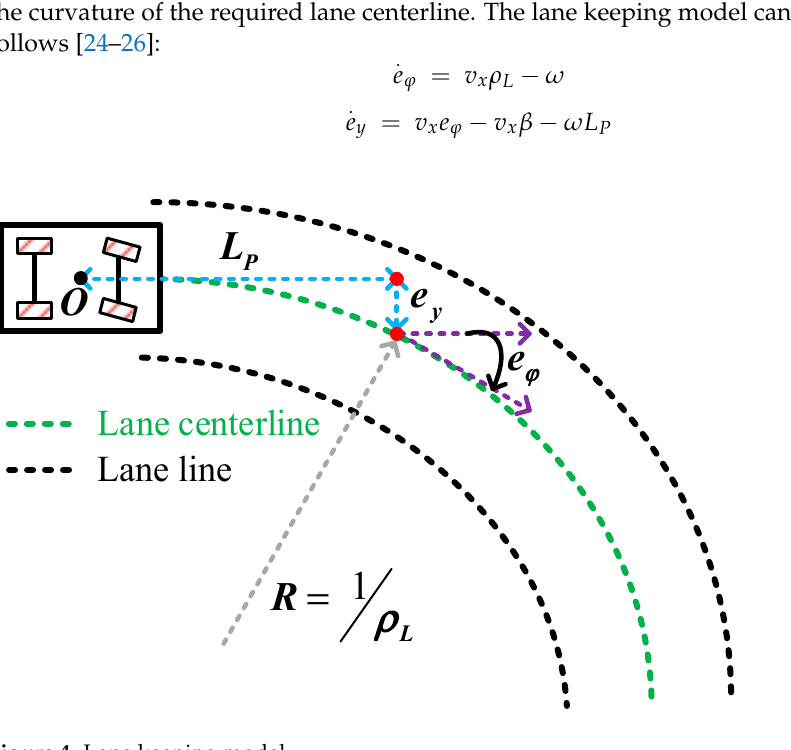
Figure 4. Lane keeping